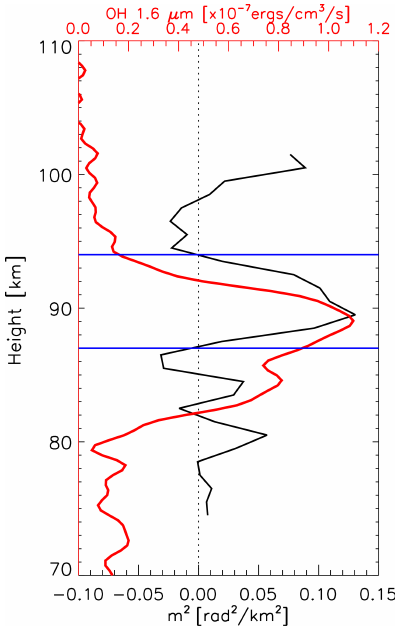
Figure 13. Square of vertical wave number m 2 profile (black) de- rived from the temperature from the TIMED–SABER measurement location at 04:18:49LT and the meteor radar wind from the Beijing station marked in Fig. 9. The red line represents the OH 1.6µm emission intensity obtained by the TIMED–SABER. The horizon- tal blue lines represent the top and bottom boundaries of the duct